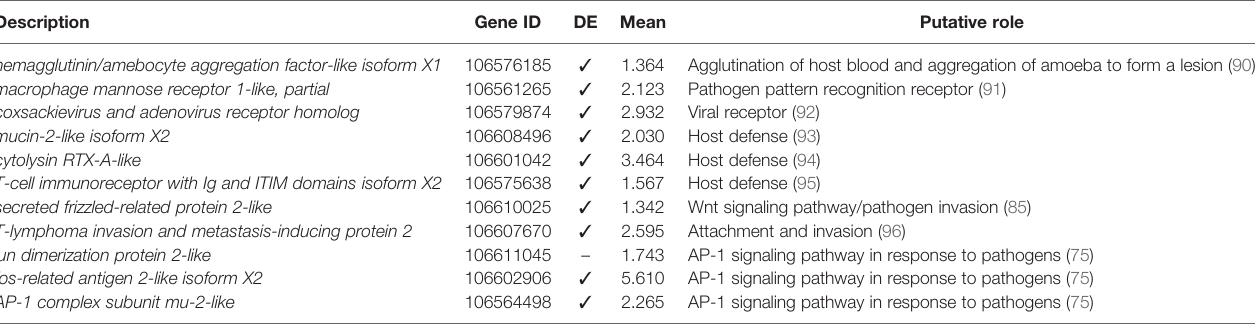
TABLE 3 | Selected genes expressed (fold change > 2; P < 0.05) in the gills from the z inc fi nger OZF-like gene regulatory network with potential activity in the host- parasite response to amoebic gill disease (AGD). Description Putative